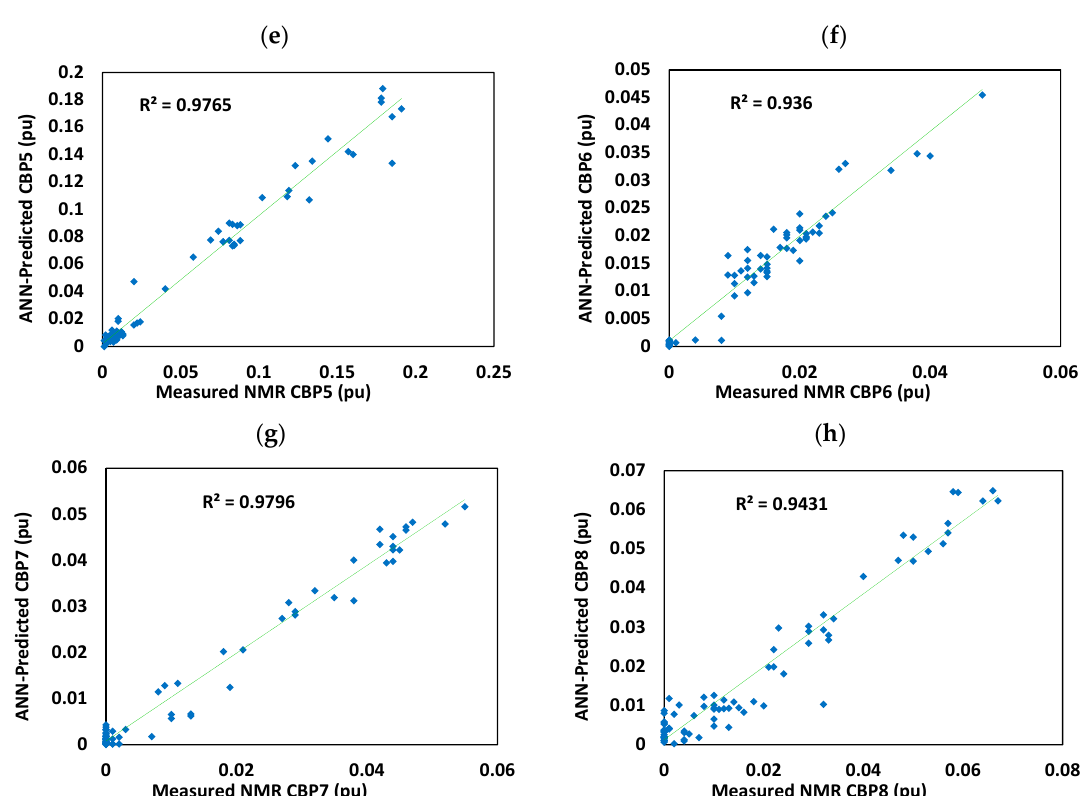
Figure 9. Correlations of the measured values of bin porosities with the predicted values (pu indicates the porosity unit): ( a ) CBP1; ( b ) CBP2; ( c ) CBP3; ( d ) CBP4; ( e ) CBP5; ( f ) CBP6; ( g ) CBP7; ( h ) CBP8.